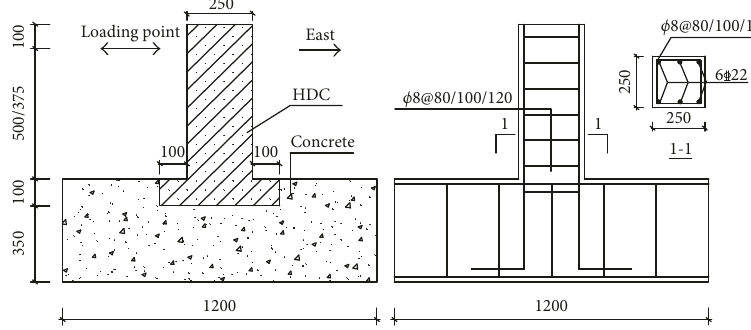
Figure 2: Geometry and reinforcement details (unit: mm).